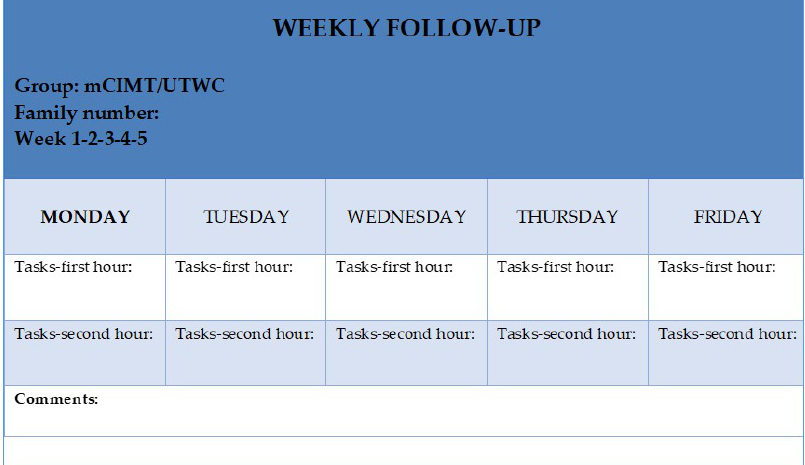
Figure 1. Weekly follow-up for